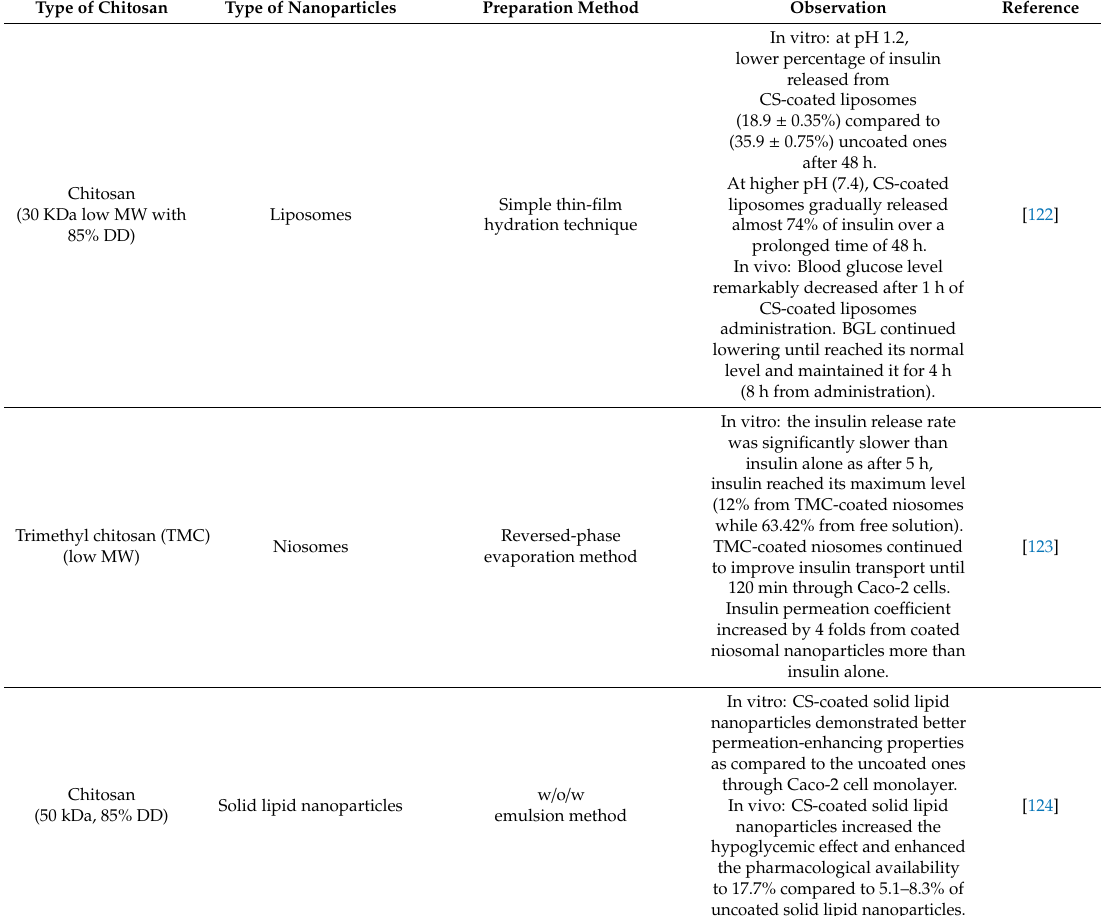
Table 4. Examples of chitosan and chitosan-derivatives as coating